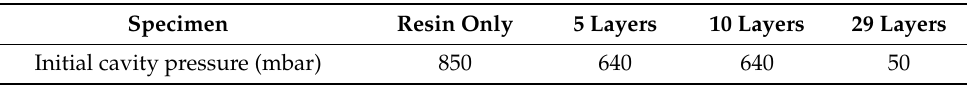
Table 2. Initial gas pressure (evacuation) inside the cavity at the beginning of the resin infusion. Specimen Resin Only 5 Layers 10